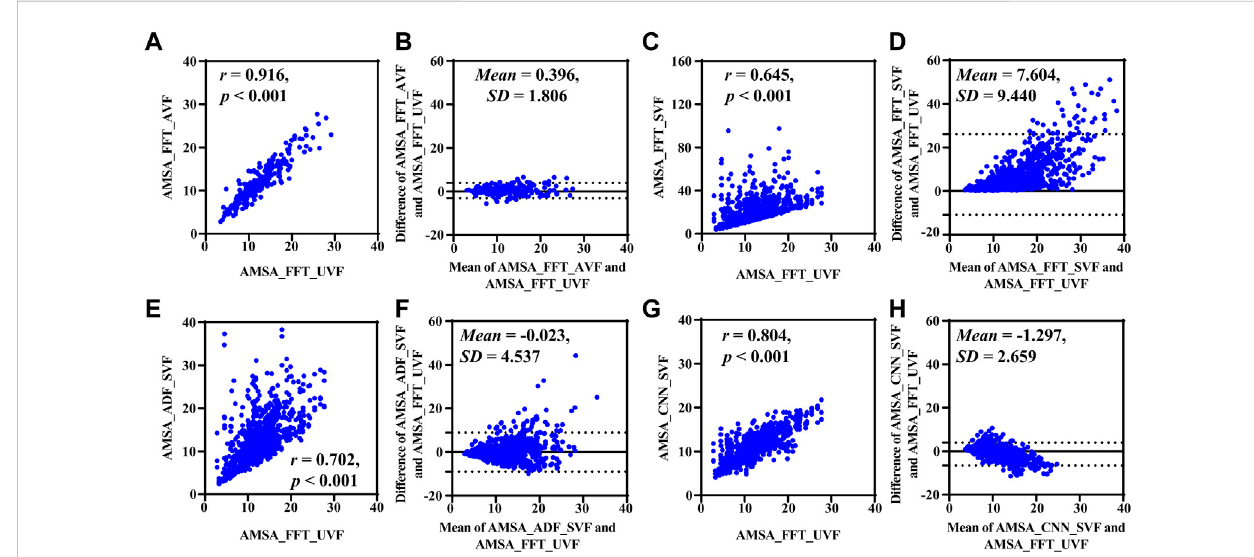
Performanceresultsonsimulateddata. (A) Relationshipand (B) differencebetweenAMSA_FFTofadjacentVFandtruevalue. (C) Relationshipand (D) difference between the AMSA_FFT of the corrupted VF and true value. (E) Relationship and (F) difference between AMSA_ADF of corrupted VF and true value. (G) Relationship and (H) difference between the AMSA_CNN of the corrupted VF and true